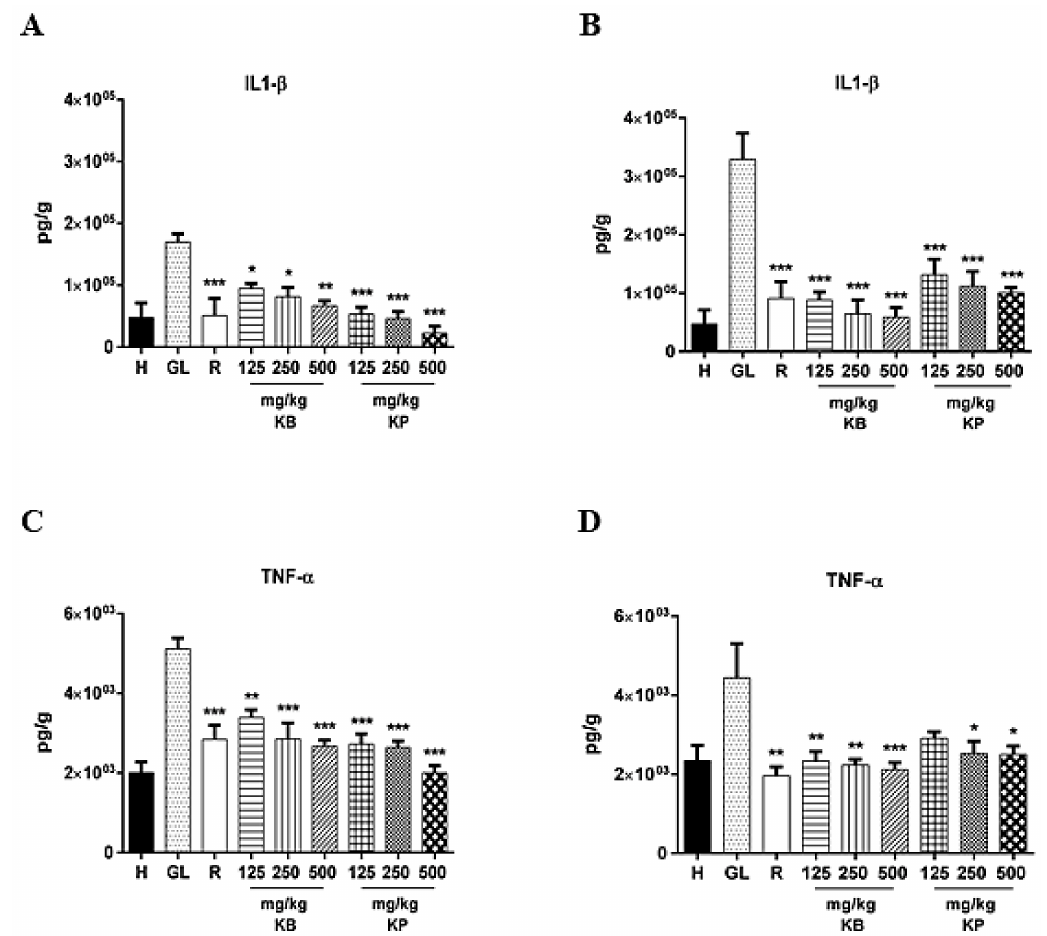
Figure 5. Effect of pre-treatment with K. brasiliensis and K. pinnata leaf juice (125, 250 and 500 mg/kg) on IL-1 β (( A ) ethanol-induced and ( B ) indomethacin-induced) and TNF- α (( C ) ethanol-induced and ( D ) indomethacin-induced) in the gastric mucosa homogenate of lesions in rats. Results expressed as mean ± standard mean error, ( n = 7). ANOVA and Tukey post-test were used to calculate the statistical significance, * p < 0.05, ** p < 0.01 and *** p < 0.001 vs. gastric lesion control. Healthy, H; Gastric lesion control, GL; Ranitidine (50 mg/kg),